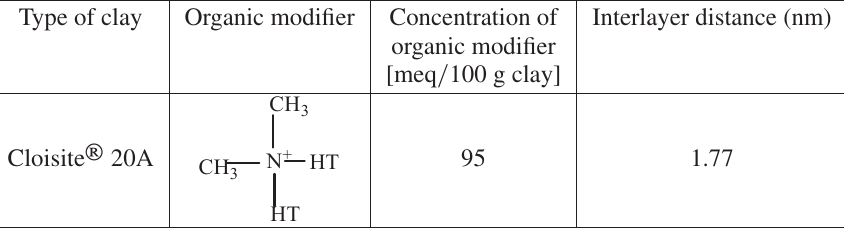
Table 1. Organic modifiers and Interlayer Distance of the clays. spectra were recorded on Galaxy Series FTIR 5000 spec- trophotometer (England). Vibration transition frequencies were reported in wave number (cm (cid:3) 1 D 10 (cid:3) 2 m (cid:3) 1 ). UV- visible spectra were recorded at 298 K in the 250–700 nm spectral regions with a Perkin Elmer Lambda 15 spec- trophotometer in NMP solution using cell lengths of 1